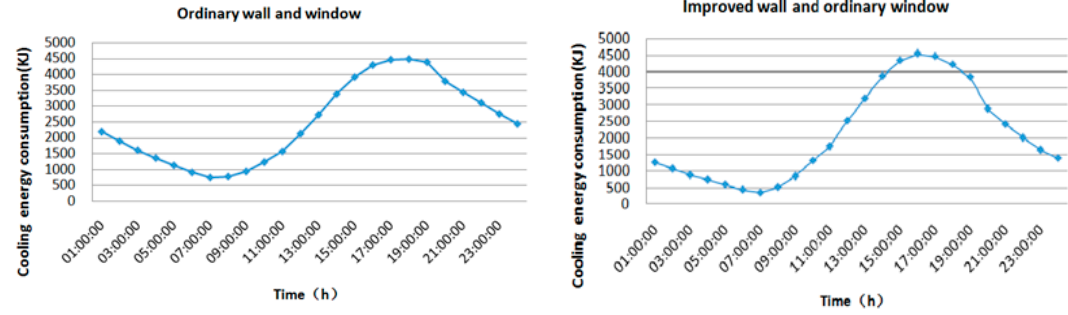
Figure 8. Energy consumption of different building envelopes.